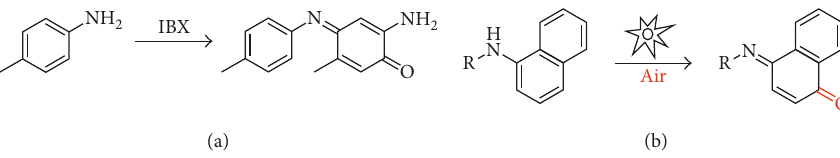
Scheme 1: Photooxygenations and self-sensitizations of naphthylamine strategies. (a) Previous work [4]. (b) Our